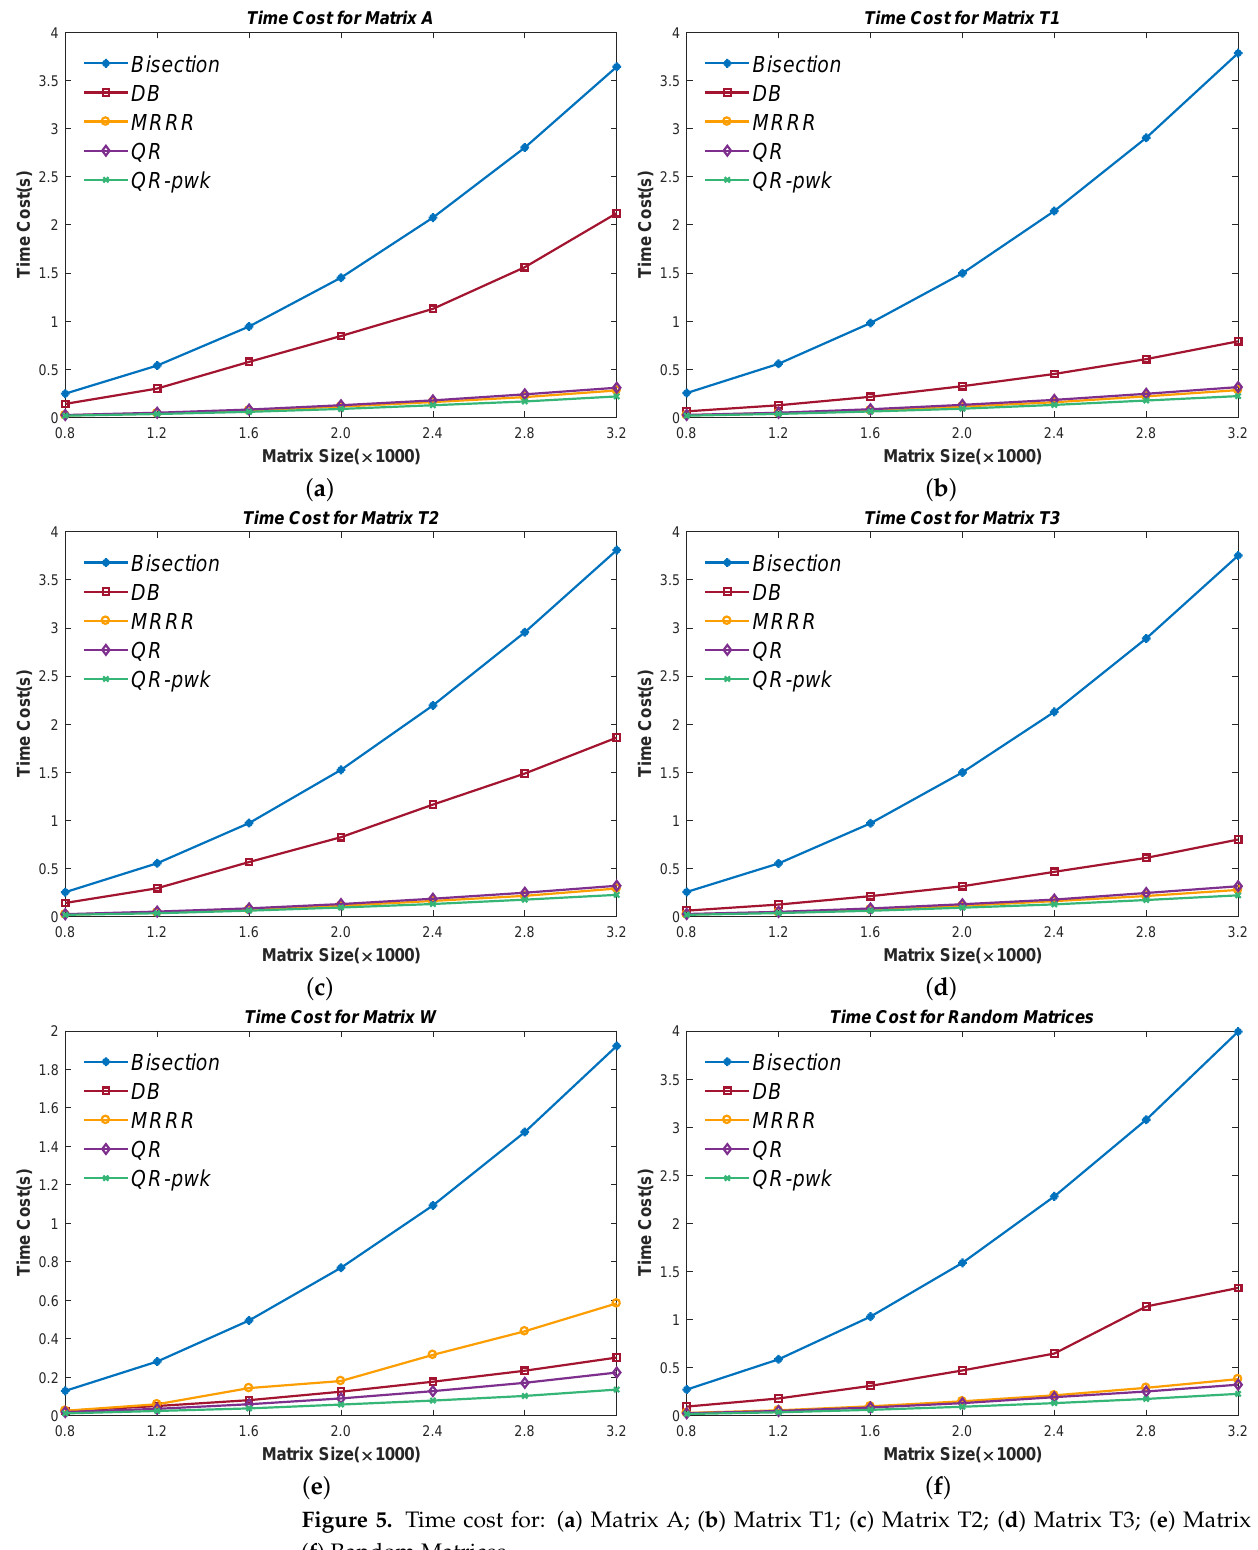
Figure 5. Time cost for: ( a ) Matrix A; ( b ) Matrix T1; ( c ) Matrix T2; ( d ) Matrix T3; ( e ) Matrix W; ( f ) Random